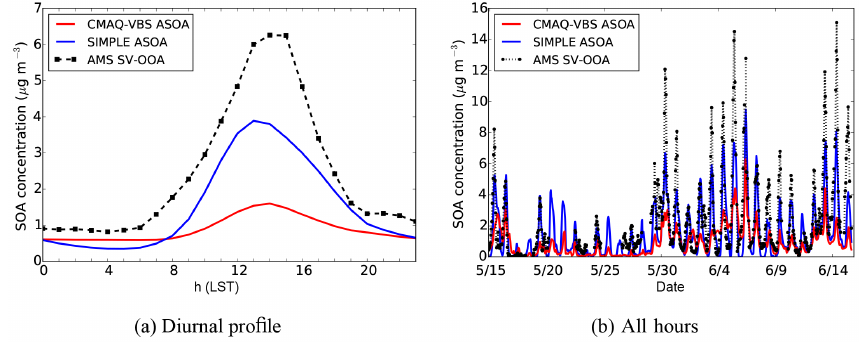
Figure 9. Comparison of the SIMPLE SOA parameterization in CMAQ to CMAQ-VBS SOA and AMS OOA (a) diurnal cycle and (b) all hours at the Pasadena CalNex